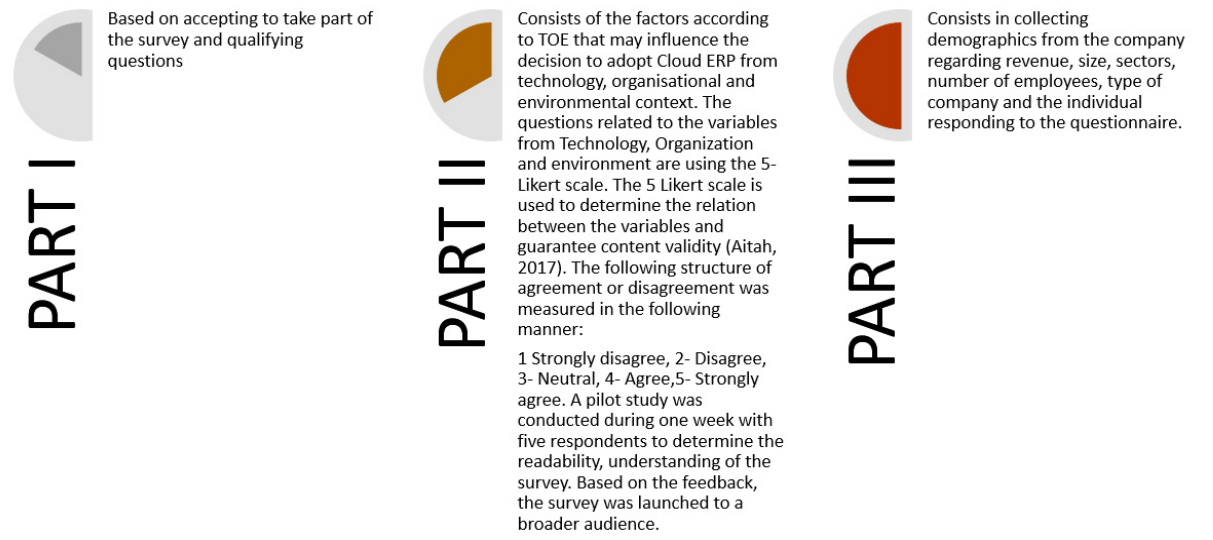
Figure 10. Survey structure.